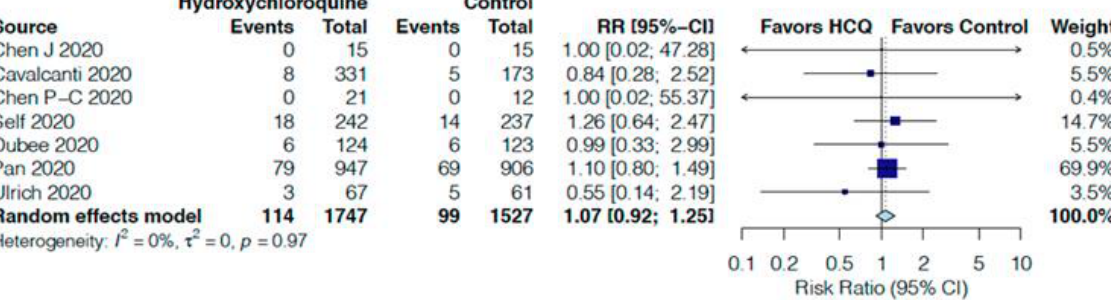
Figure 3. Effect of hydroxychloroquine on all-cause mortality at 14 days in hospitalized COVID-19 patients. Figure 4. Effect of hydroxychloroquine on all-cause mortality at 30 days in hospitalized COVID-19 patients.